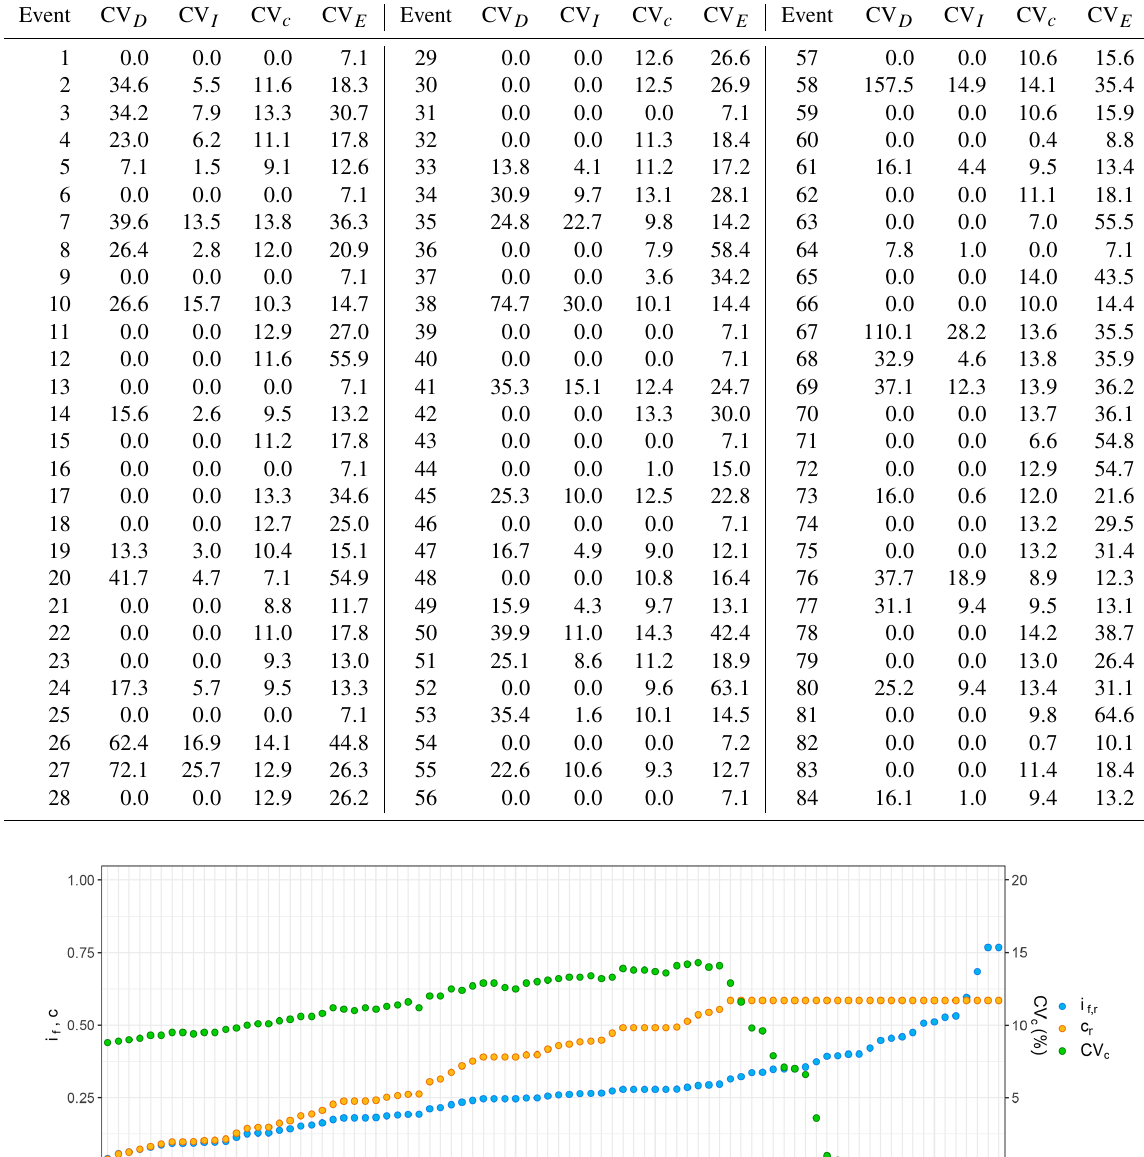
Table 2. Coefficients of variation of the event characteristics related to each debris flow expressed as a percentage. CV D is the coefficient of variation of the duration distribution, CV I is the coefficient of the intensity distribution, and CV c is the coefficient of the concentration distribution and CV E is the coefficient of the rainfall volume per unit area distribution.